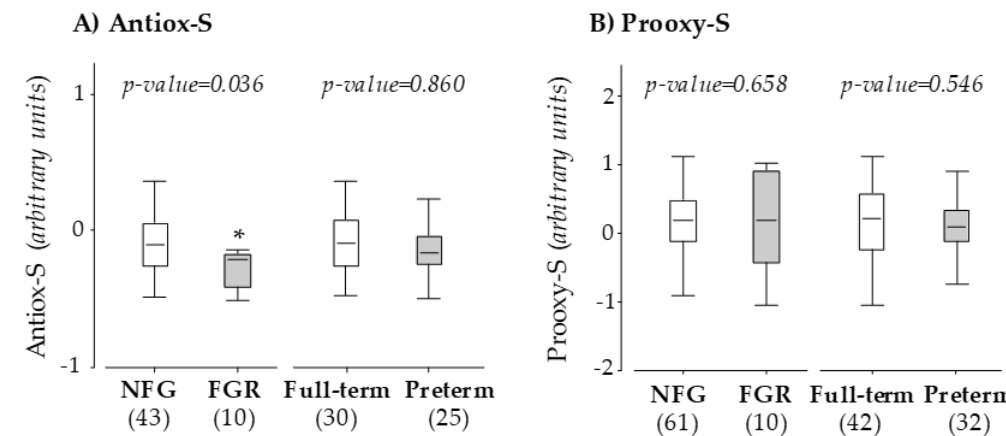
Figure 1. Maternal Antiox-S ( A ) and Prooxy-S ( B ) at 10 weeks of gestation. Data compare pregnant women with normal fetal growth (NFG) versus fetal growth restriction (FGR) and women with full-term versus preterm labor. Graphs show the median and interquartile range (IQR). Sample size is shown between brackets; * p < 0.05, U Mann–Whitney test.